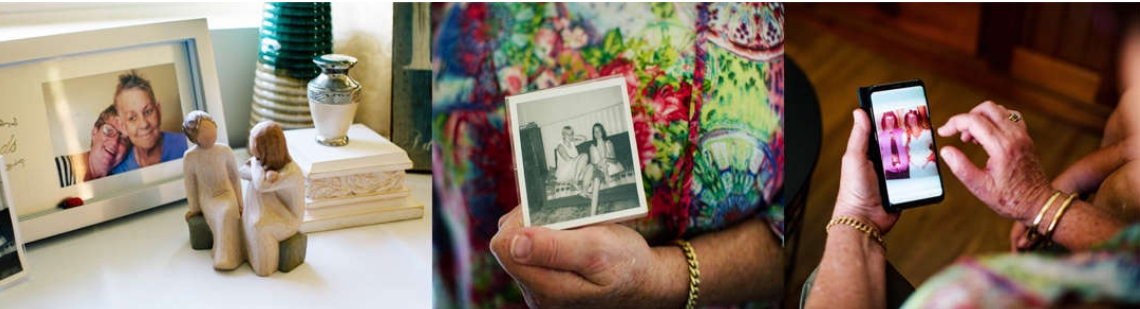
Figure 6. Professional photographs of carers, with their memoires.